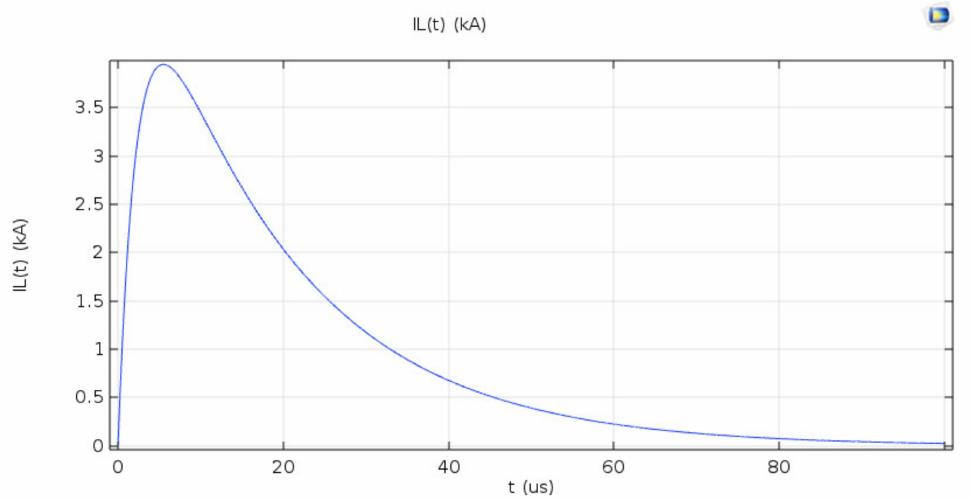
Figure 5. Lightning current waveform in